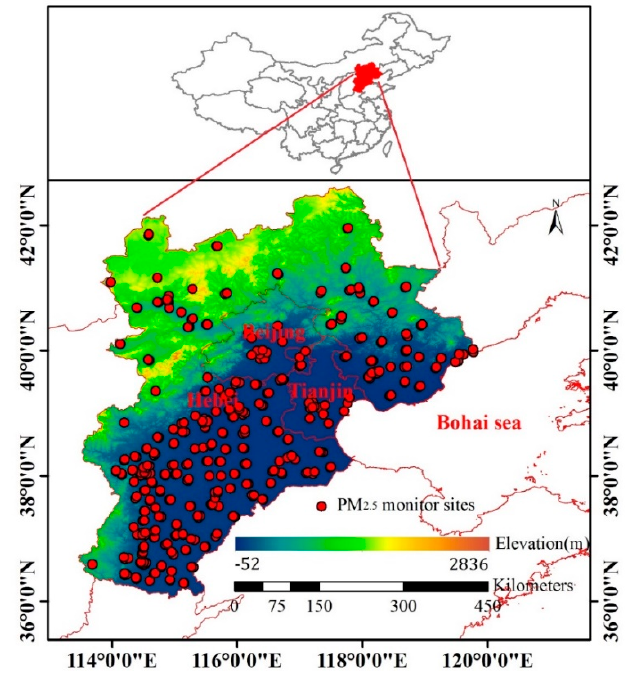
Figure 2. Study area. Figure 2. Study